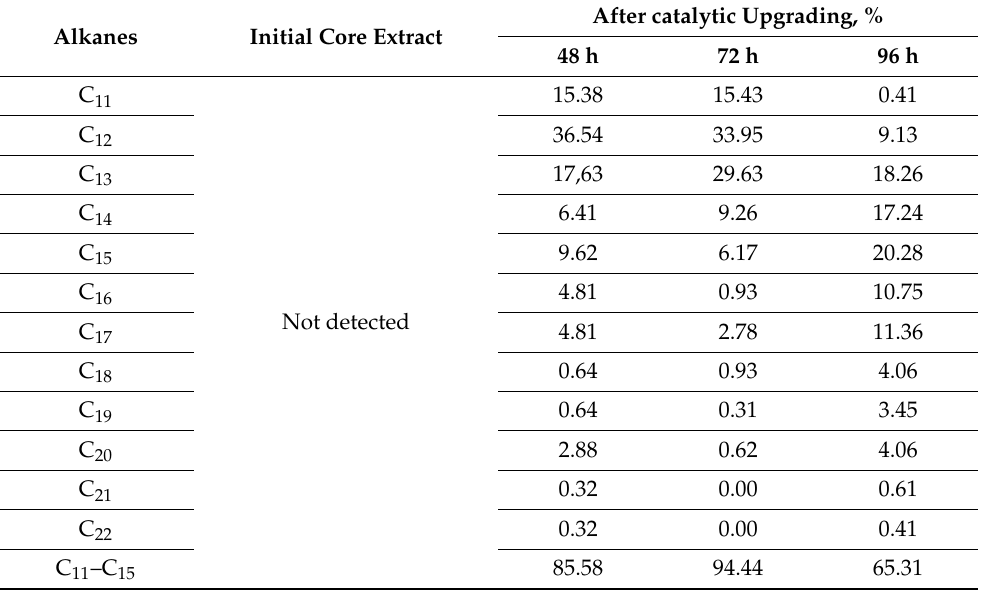
Table 3. Relative content of normal alkanes in saturated hydrocarbon fractions after catalytic upgrad- ing of crushed cores for different durations. Alkanes